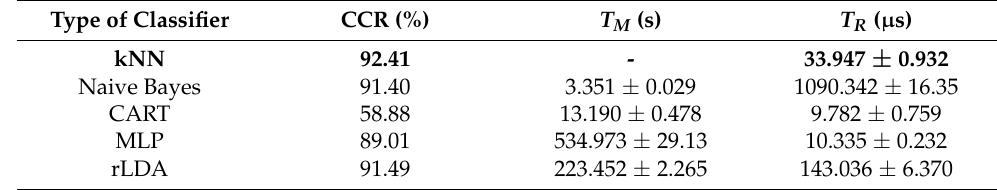
Table 4. Classification results for individual classifiers with Group 3 attributes.